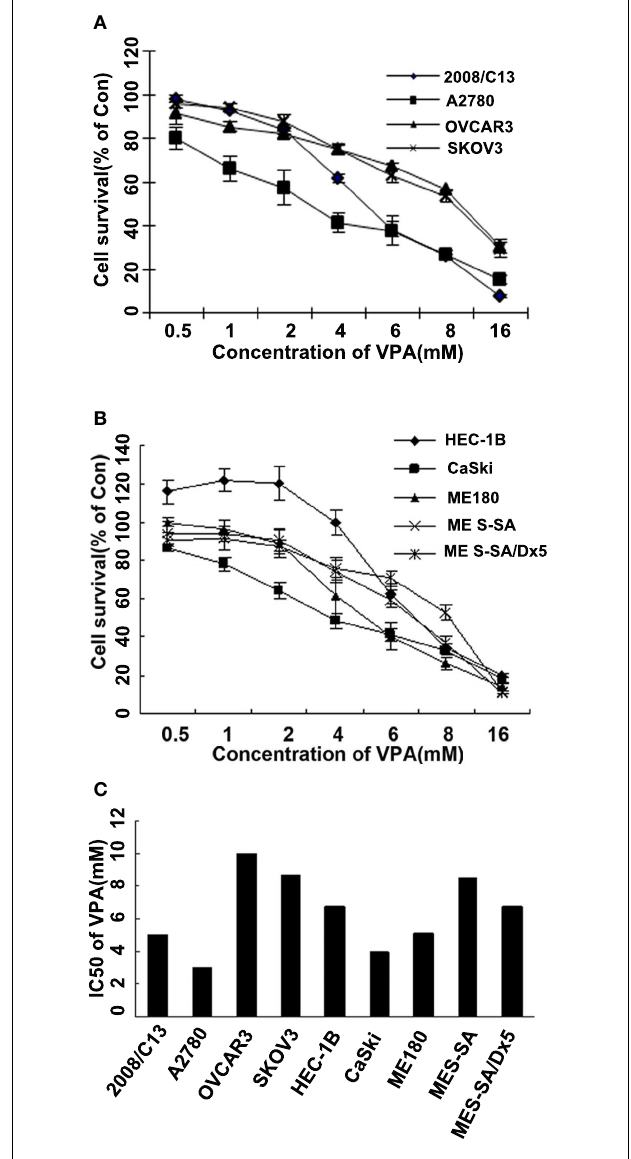
FIGURE 1 | Cytotoxicity in gynecologic cancer cell lines after 72h of treatment withVPA alone. (A) Growth curves for ovarian cancer cell lines (2008/C13, A2780, OVCAR3, and SKOV3) after treatment withVPA alone at increasing concentrations (0.5–16mM). (B) Growth curves for uterine and cervical cancer cell lines (ME180, CaSki, HEC-1B, MES-SA, and MES-SA/D × 5) after treatment withVPA alone at increasing concentrations (0.5–16mM). (C) IC 50 ofVPA treatment in the nine gynecologic cancer cell lines